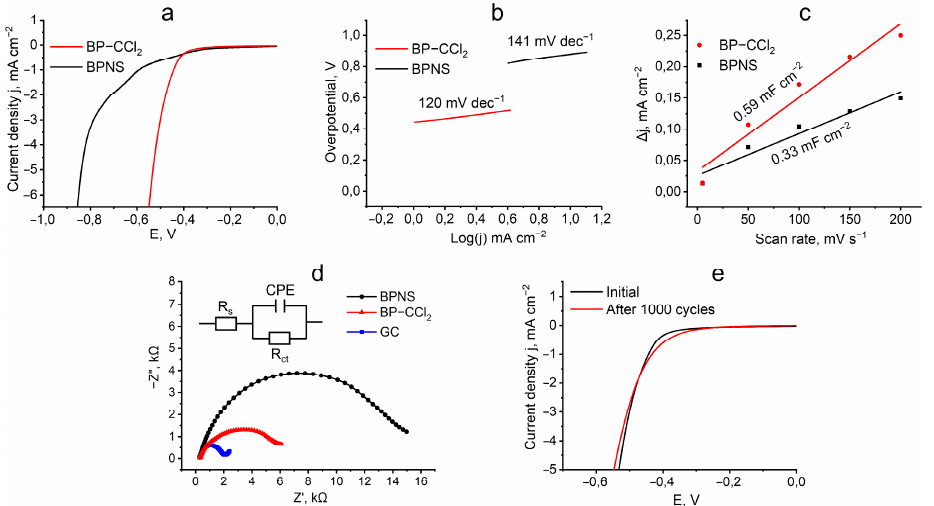
Figure 7. ( a ) LSV curves of BPNS and BP–CCl 2 (vs. RHE) for the electrocatalytic HER at a scan rate of 5 mV s − 1 in 1 M KOH. ( b ) Tafel plots for BP and BP–CCl 2 . ( c ) The fitting curve of BPNS and BP–CCl 2 between scan rate and current density variation ( Δ j = j anode –j cathode ) at 50 mV (vs. RHE). ( d ) Nyquist diagrams of BPNS, BP–CCl 2 , and glassy carbon electrode. The inset shows the equivalent circuit consisting of solution resistance, R s , charge-transfer resistance, R ct , and constant phase element (CPE). ( e ) LSV curves of BP–CCl 2 initially and after 1000 cycles of CV recordings. Table 1. The EIS parameters (R s , R ct , CPE, and the value of the exponent of the CPE (n)) obtained by fitting Nyquist diagrams using the equivalent circuit.